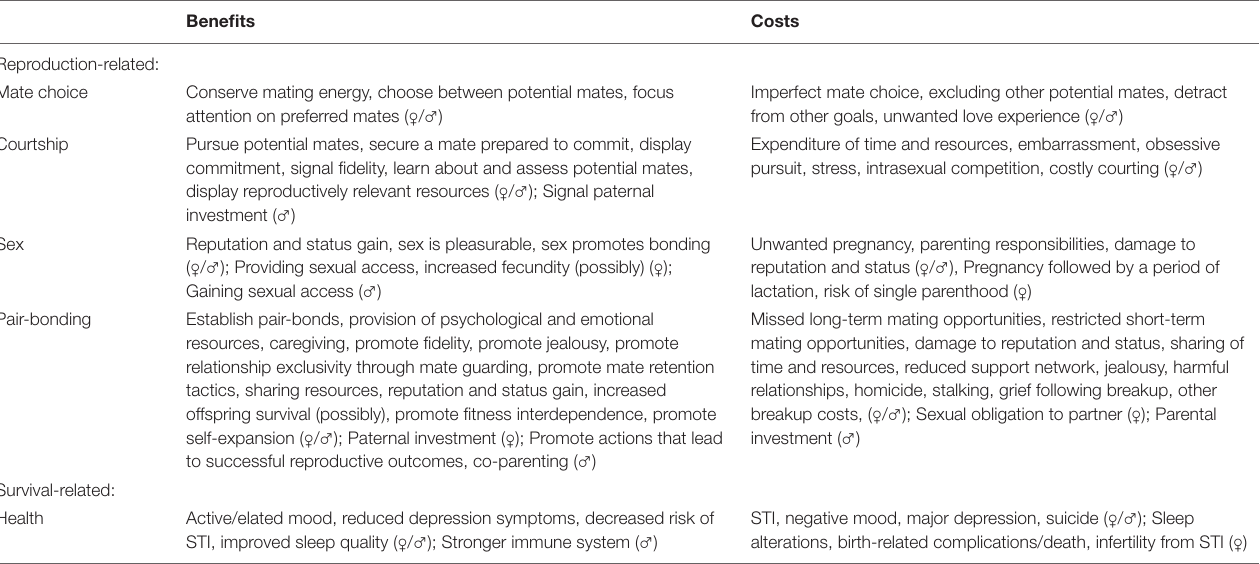
TABLE 3 | Reproduction- and survival-related benefits and costs associated with each function of romantic love. Benefits